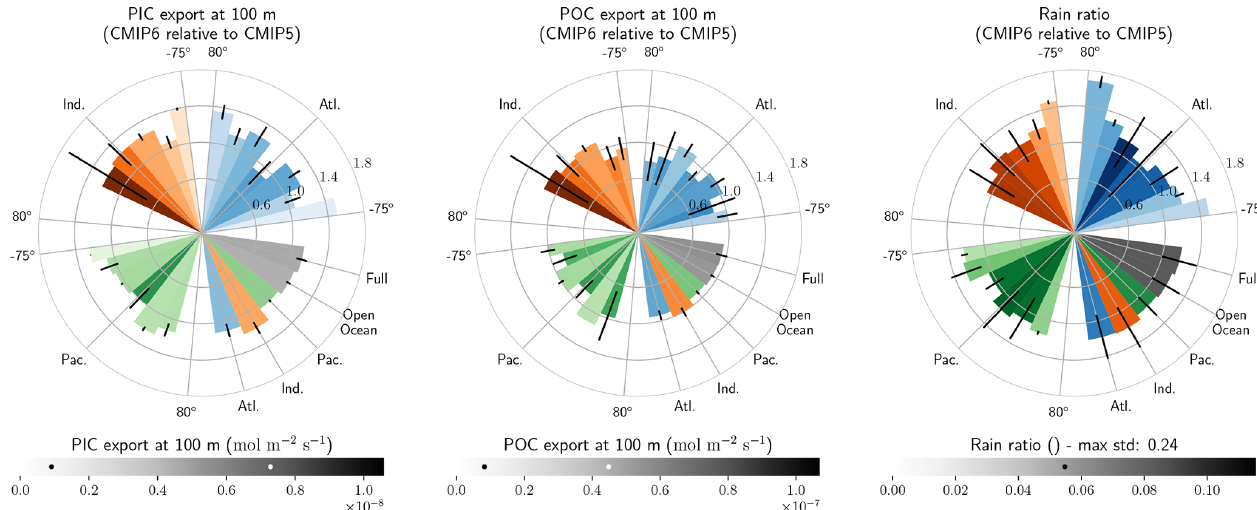
Figure D2. Spatial distribution of the PIC and POC exports at 100m. The PIC export, POC export and rain ratio at 100m for the Atlantic (blue), Indian (orange) and Pacific (green) basins and meridional sub-regions of each basin are shown. Bar heights give the relative difference between the CMIP6 and CMIP5 ensemble means. Bar colours give the CMIP6 ensemble mean (same shades as the grey-coloured bars). Errors are the CMIP6 standard deviation with values normalized between 0 and 0.5 (the minimum and maximum standard deviations are respectively marked by black and white points on the colour bars). Ocean basins are delineated as in Fig.